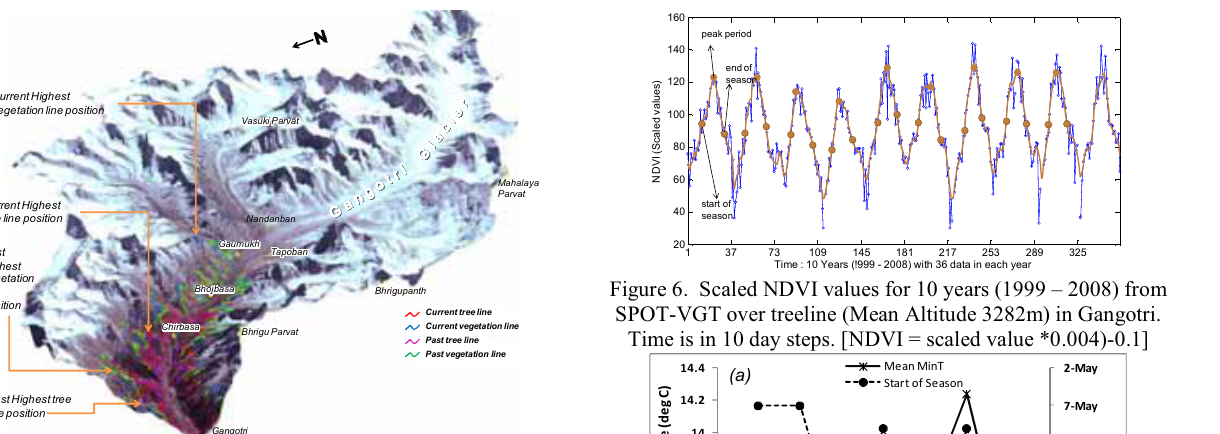
Figure 2. Perspective view showing the position of treeline and vegetation line (current/past) over IRS-P6-LISS-III FCC.